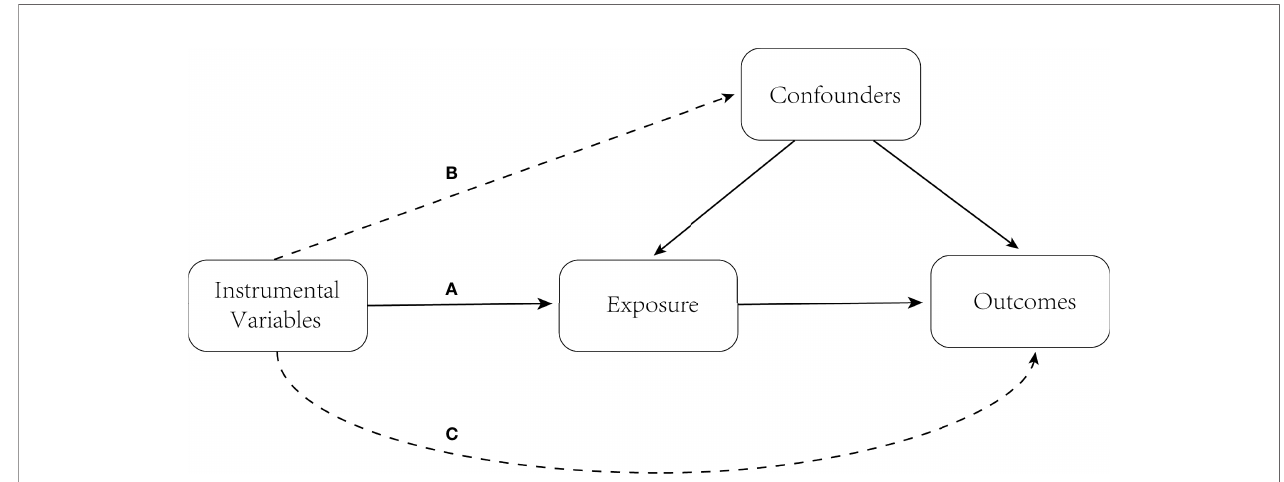
FIGURE 1 | Three key assumptions of MR study. (A) The instrumental variables must be associated with exposure (PA); (B) instrumental variables must be independent of confounders; and (C) instrumental variables should not be directly associated with outcomes (AS). MR, Mendelian randomization; PA, physical activity; AS, ankylosing